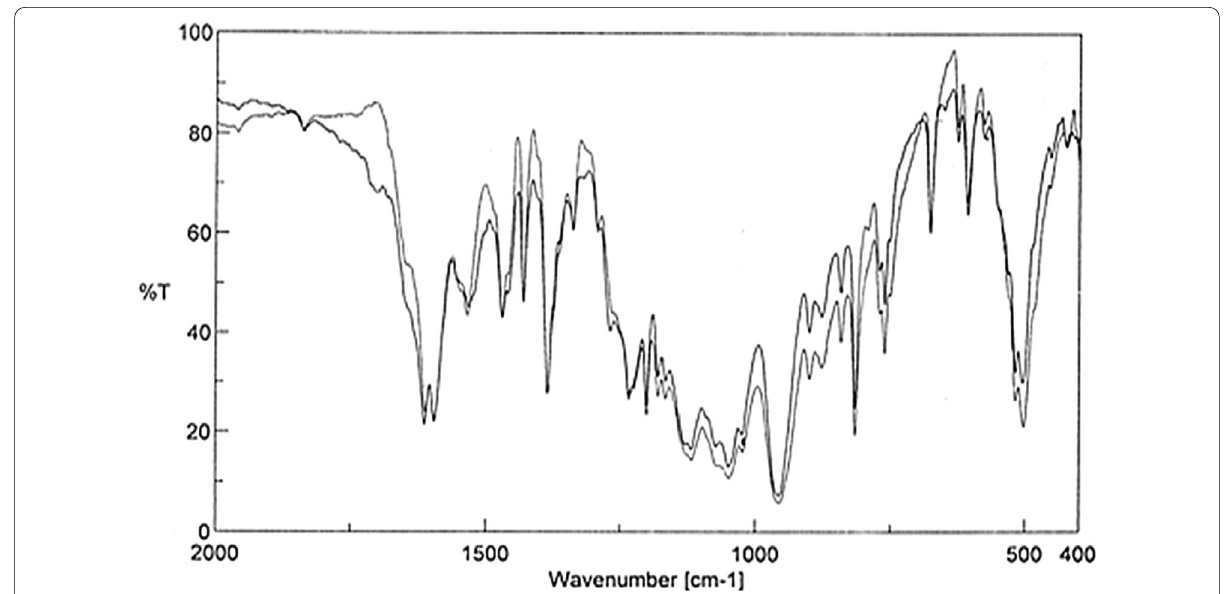
Fig. 1 FT-IR spectrum of primaquine